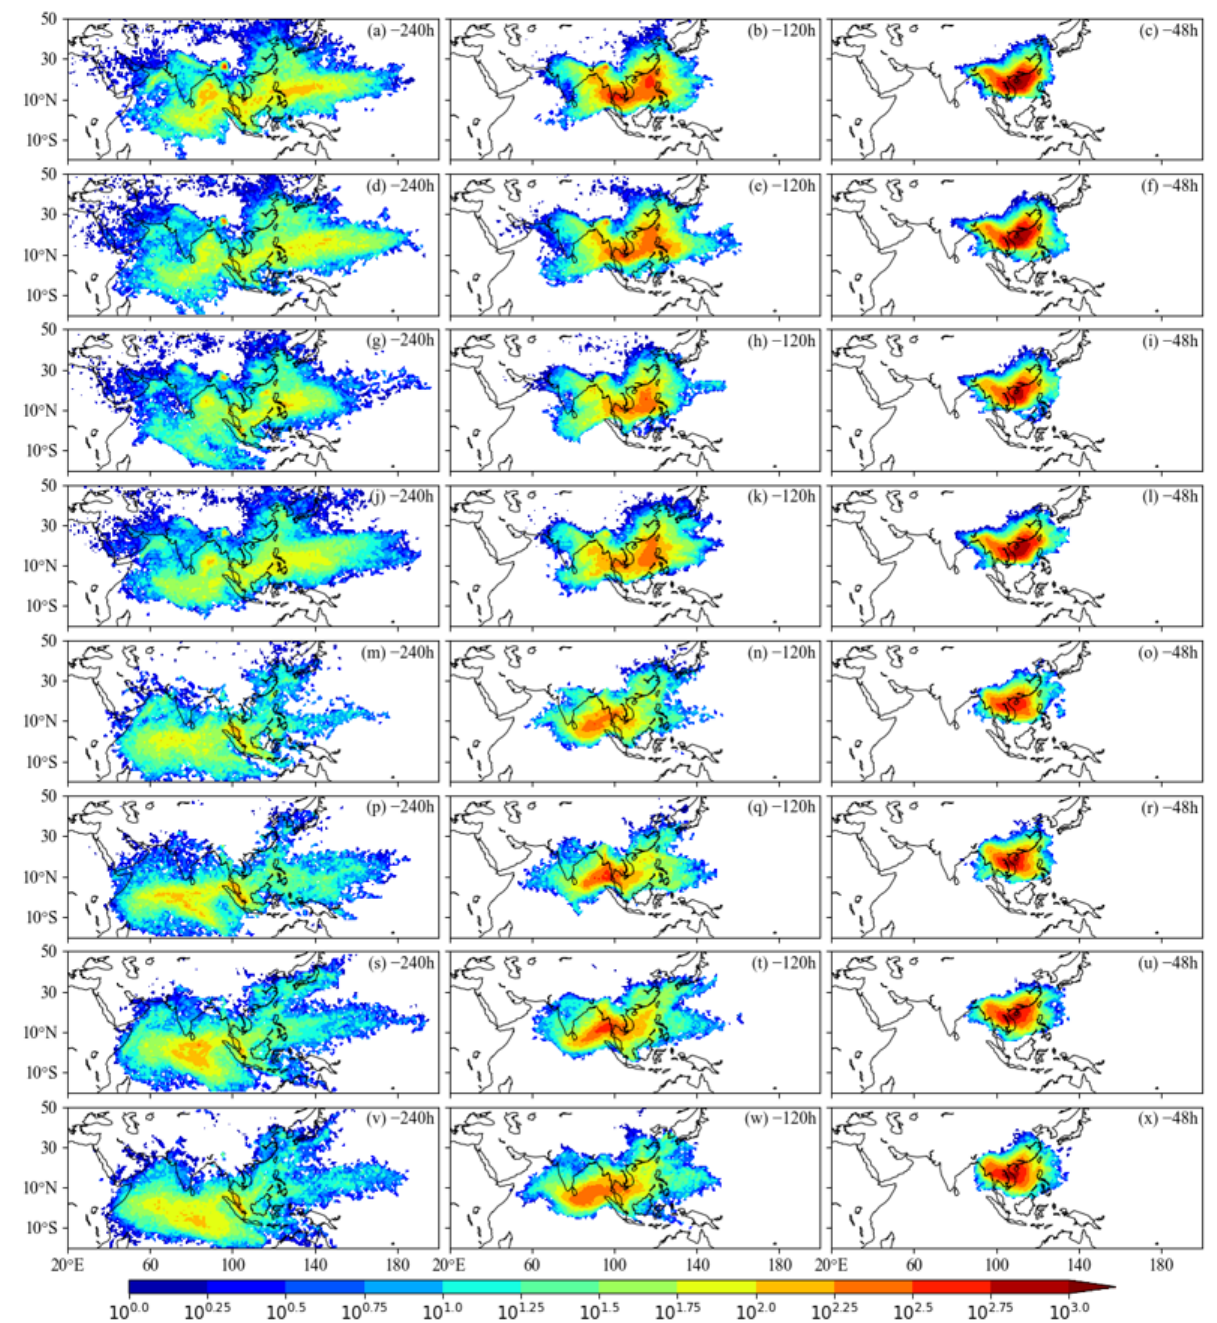
Figure 2. Distribution of cumulative specific humidity of each 1 ◦ × 1 ◦ grid on the water vapor transport trajectories in the preflood season (1960–2012) 10 days, 5 days, 2 days before the water vapor reaches South China.(( a – l ) for the frontal precipitation, ( m – x ) for the monsoon